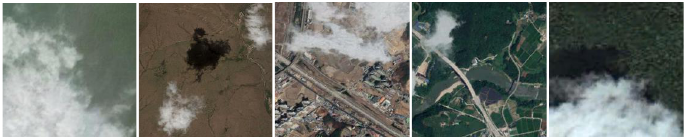
Figure 8. Partial sample display of cloud and cloud shadow